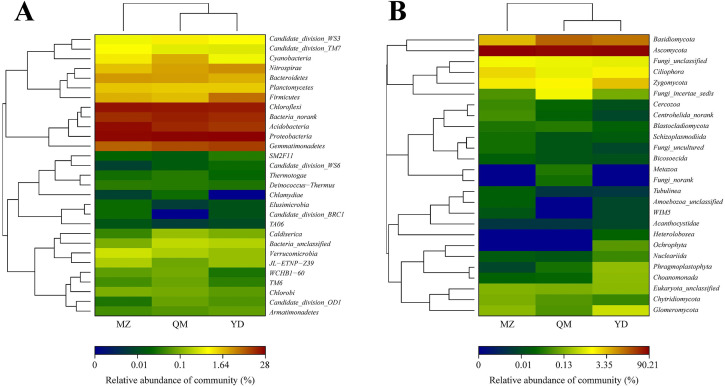
Heat map of soil bacterial (A) and fungal (B) communities of three soils.MZ = continuous cropping proso millet for 5 years, YD = continuous cropping common bean for 5 years, QM = continuous cropping common buckwheat for 5 years. Different Color indicates the relative abundance of the phyla in the total community.